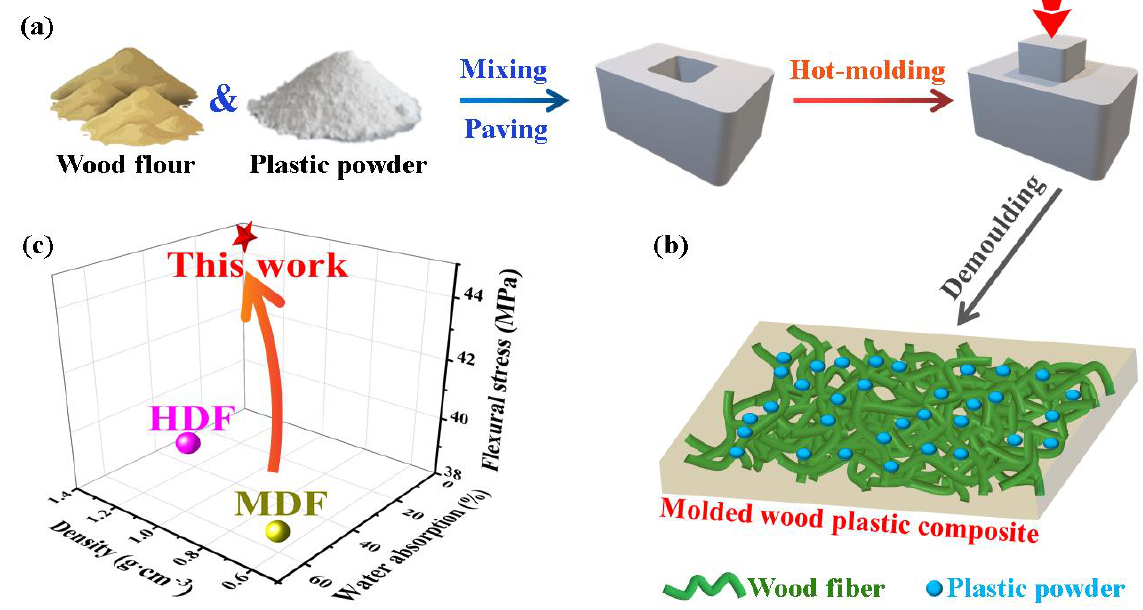
Figure 1. ( a ) Production process of WPC. ( b ) The schematic illustration of moulded wood plastic composite. ( c ) The mechanical and hydrophobic properties of WPC compared with those of MDF and HDF.